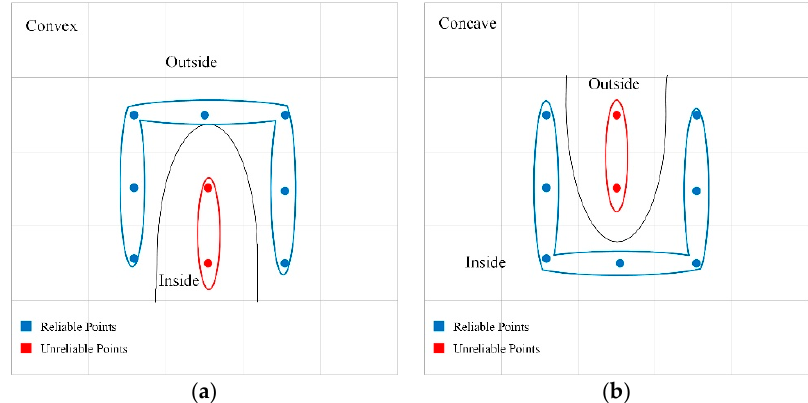
Figure 11. The distribution of reliable and unreliable points in weak regions of convex and concave surfaces; reliable voxel centers are blue, unreliable voxel centers are red; ( a ) distribution of weak regions for convex surfaces; ( b ) distribution of weak regions for concave surfaces.